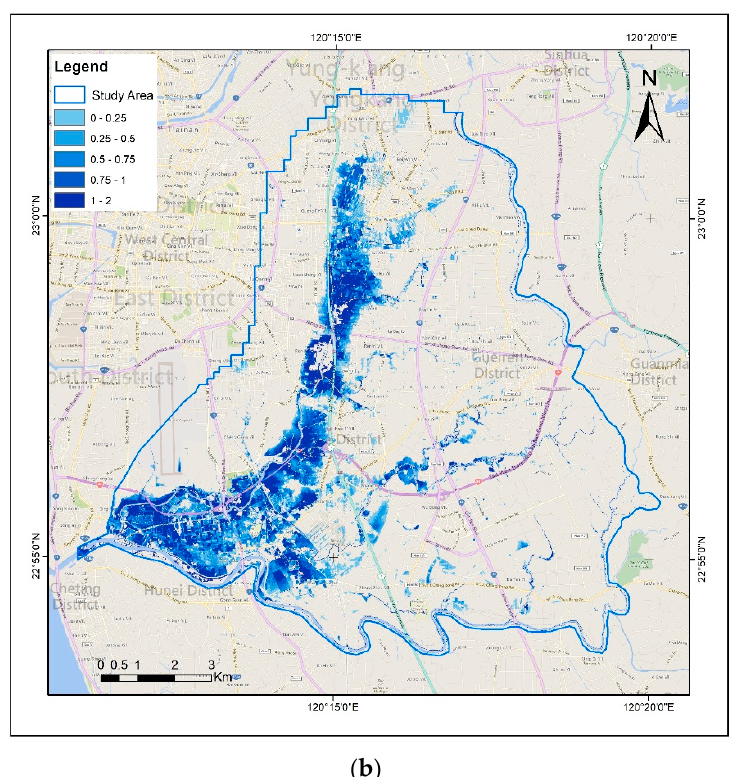
Figure 4. Flood hazard map: maximum flooding water depth during ( a ) 2016 Typhoon Megi and ( b ) 2017 Typhoon Haitang (unit: m). Table 1. Depth-damage table for the residential area from the field survey.